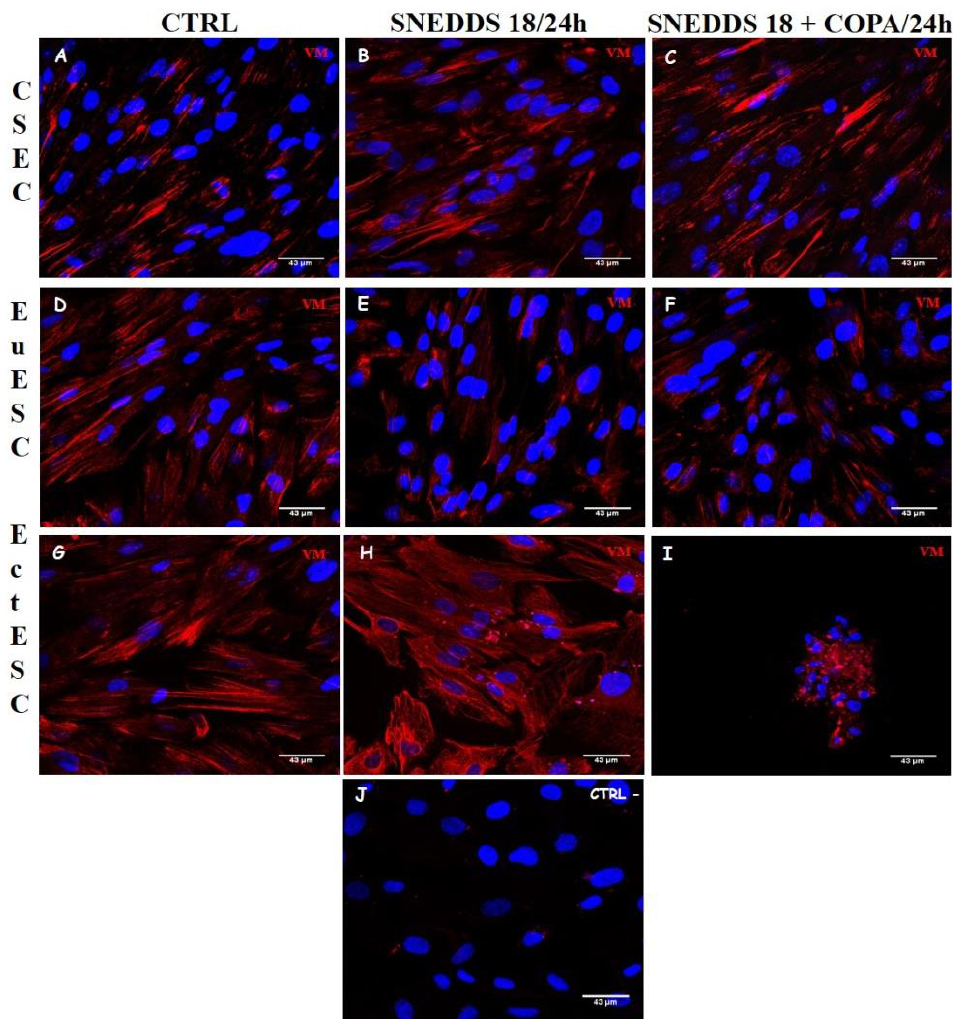
Figure 6. Morphological analysis of vimentin intermediate filaments of the ESC cultures treated with SNEDDS-18 and SNEDDS-18/COPA. CESC ( A – C ), EuESC ( D – F ), and EctESC ( G – I ) were labeled with anti-vimentin antibody (red) and DAPI ( J , nuclear marking—blue) after 24 h of treatment with nanoemulsions (50 µ g/mL). Representative images of three independent experiments performed in triplicate. Scale bar = 43 µ m. CESC: Endometrial stromal cells obtained from topic endometrium of patients without endometriosis; EuESC: Endometrial stromal cells obtained from topic endometrium of endometriosis patients; EctESC: Endometrial stromal cells obtained from ectopic endometrium of endometriosis patients (endometriotic lesions).